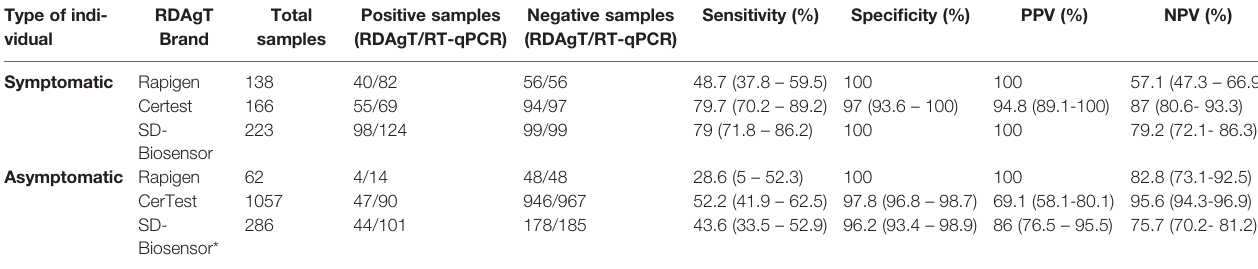
TABLE 4 | Clinical performance of the three different commercial brands of lateral fl ow immunochromatography based SARS-CoV-2 Rapid Diagnosis Antigen tests (RDAgT) included in this study for symptomatic and asymptomatic individuals (total samples: number of samples included in the evaluation; positive samples: number of SARS-CoV-2 positive samples included in the evaluation for RDAgTs or RT-qPCR; negative samples: number of SARS-CoV-2 negative samples included in the evaluation for RDAgTs or RT-qPCR; PPV: positive predictive value; NPV negative predictive value; next to the 95% con fi dence interval (IC95%). Type of indi- vidual